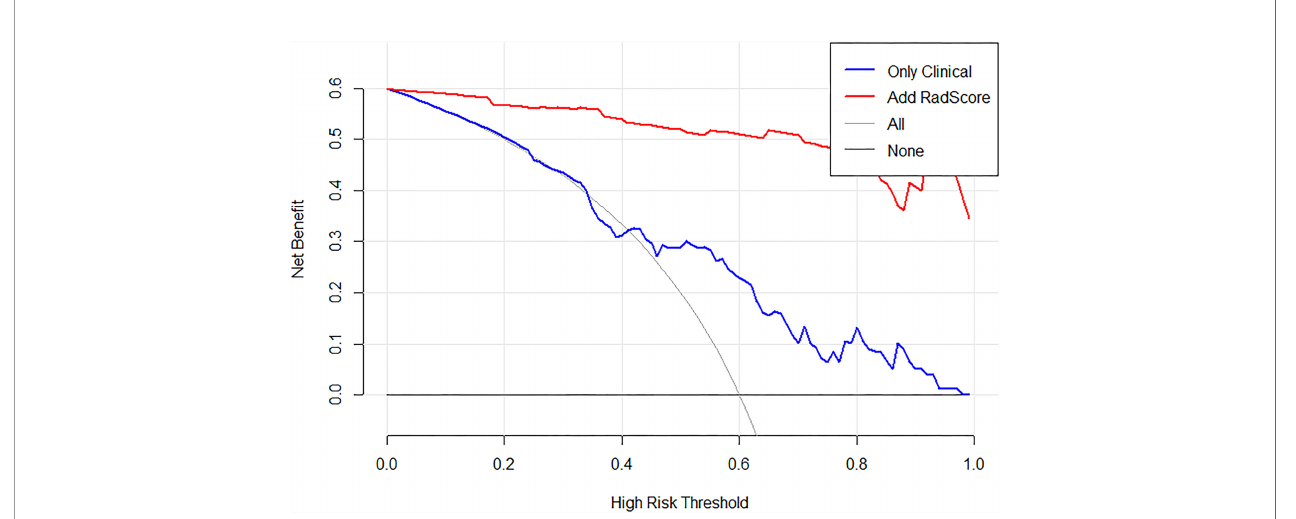
FIGURE 8 | Decision curve analysis (DCA) for the proposed radiomics nomogram, take OS_ROIB as an example. The y-axis represents the net bene fi t. The x-axis represents the threshold probability. The black line at the bottom represents the hypothesis that no patients had long-term survival. The blue line represents the hypothesis that all patients had long-term survival. The red line represents the net bene fi t of the radiomics nomogram at different threshold